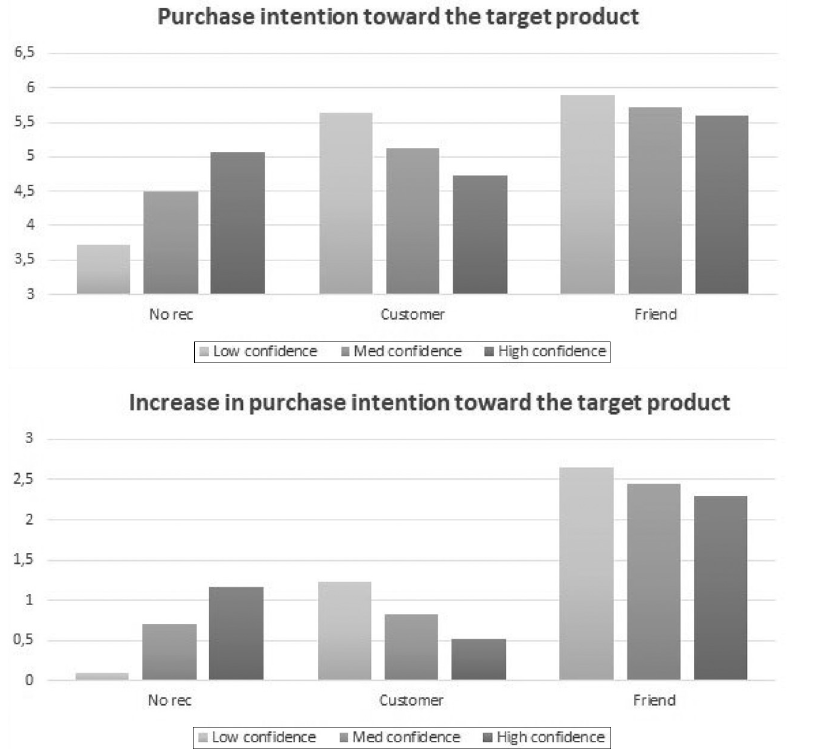
Figure 1. Interaction effects